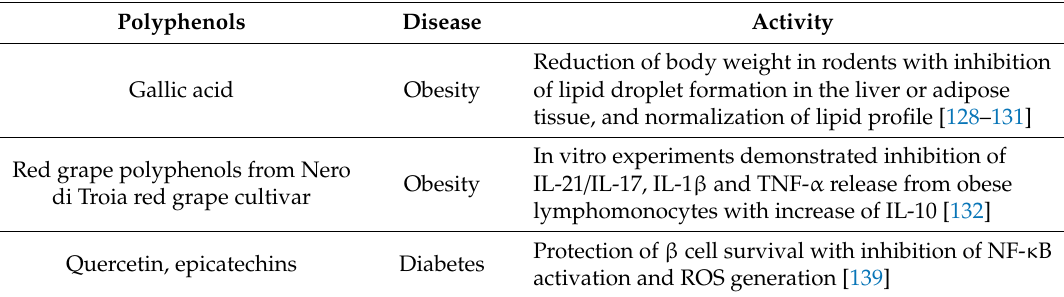
Table 3. E ff ects of red grape polyphenols on obesity / diabetes. Polyphenols Disease